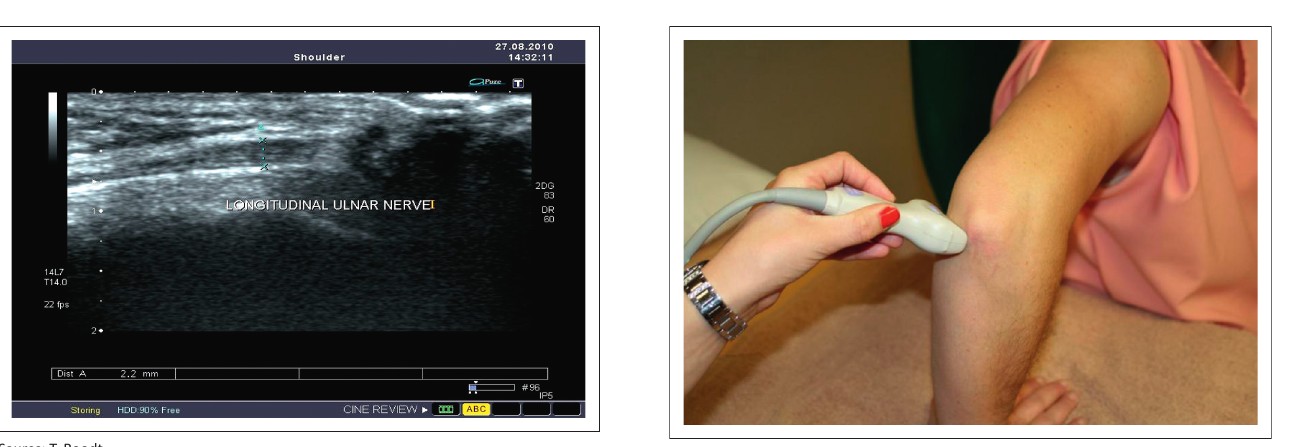
Source : T. Roodt. FIGURE 6: Transducer position for a transverse section of the ulnar nerve at the level of the cubital tunnel with the elbow in flexion. The medial aspect of the transducer (side of the marker) was placed at the medial epicondyle and the lateral aspect of the probe on the olecranon.